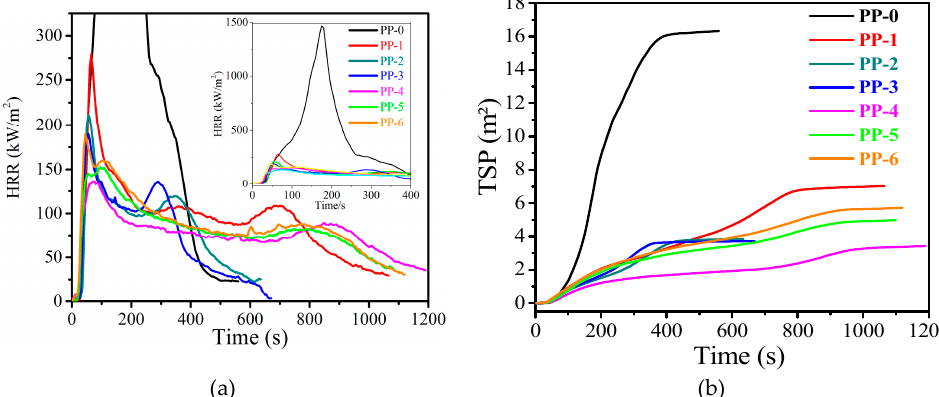
Table 2. Cone calorimetry of PP composites.